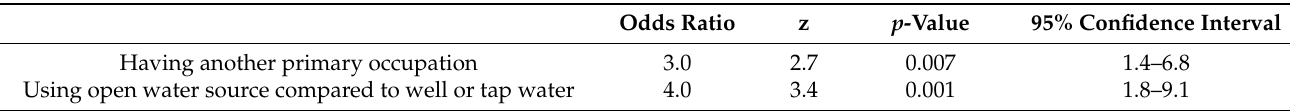
Table 3. Results from a multivariable logistic model on risk factors for a herd having at least one animal positive for Leptospira antibodies. Odds Ratio z p -Value 95% Confidence Interval Having another primary occupation Using open water source compared to well or tap